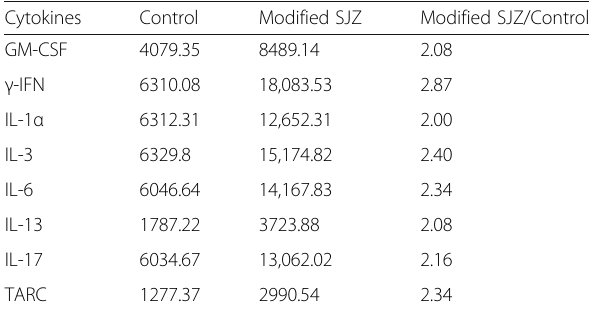
Table 2 Changes of cytokines in mice plasma after